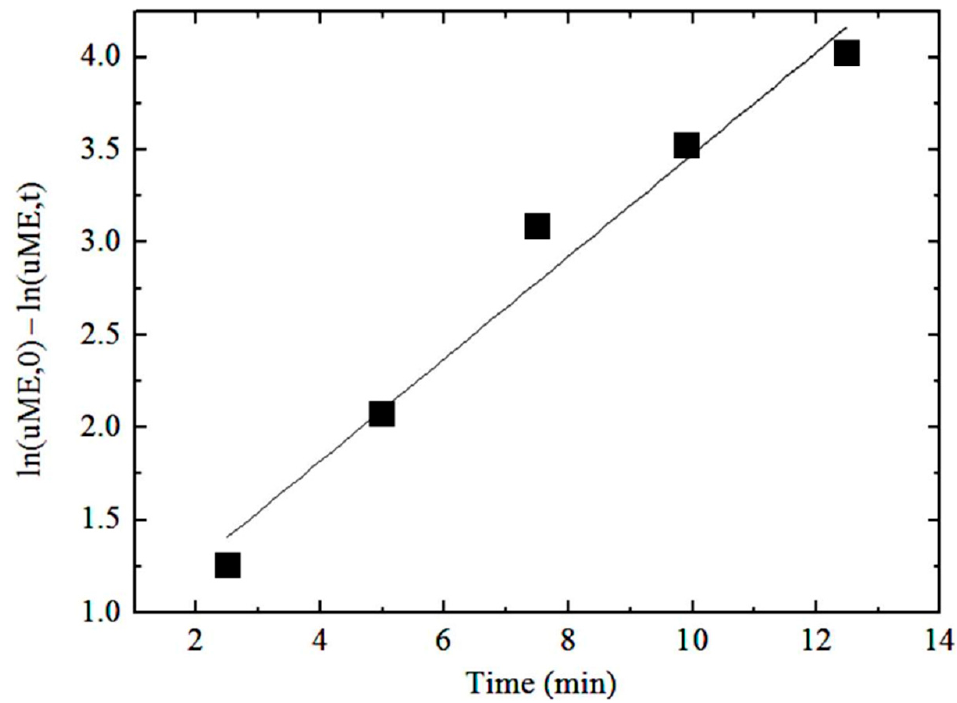
Figure 9. Plot of the value of (ln[uME, 0] – ln[uME, t]) of waste edible oil converted to biodiesel as a linear function of time t. linear function of time t. Table 3. Reaction rate constant k versus reaction